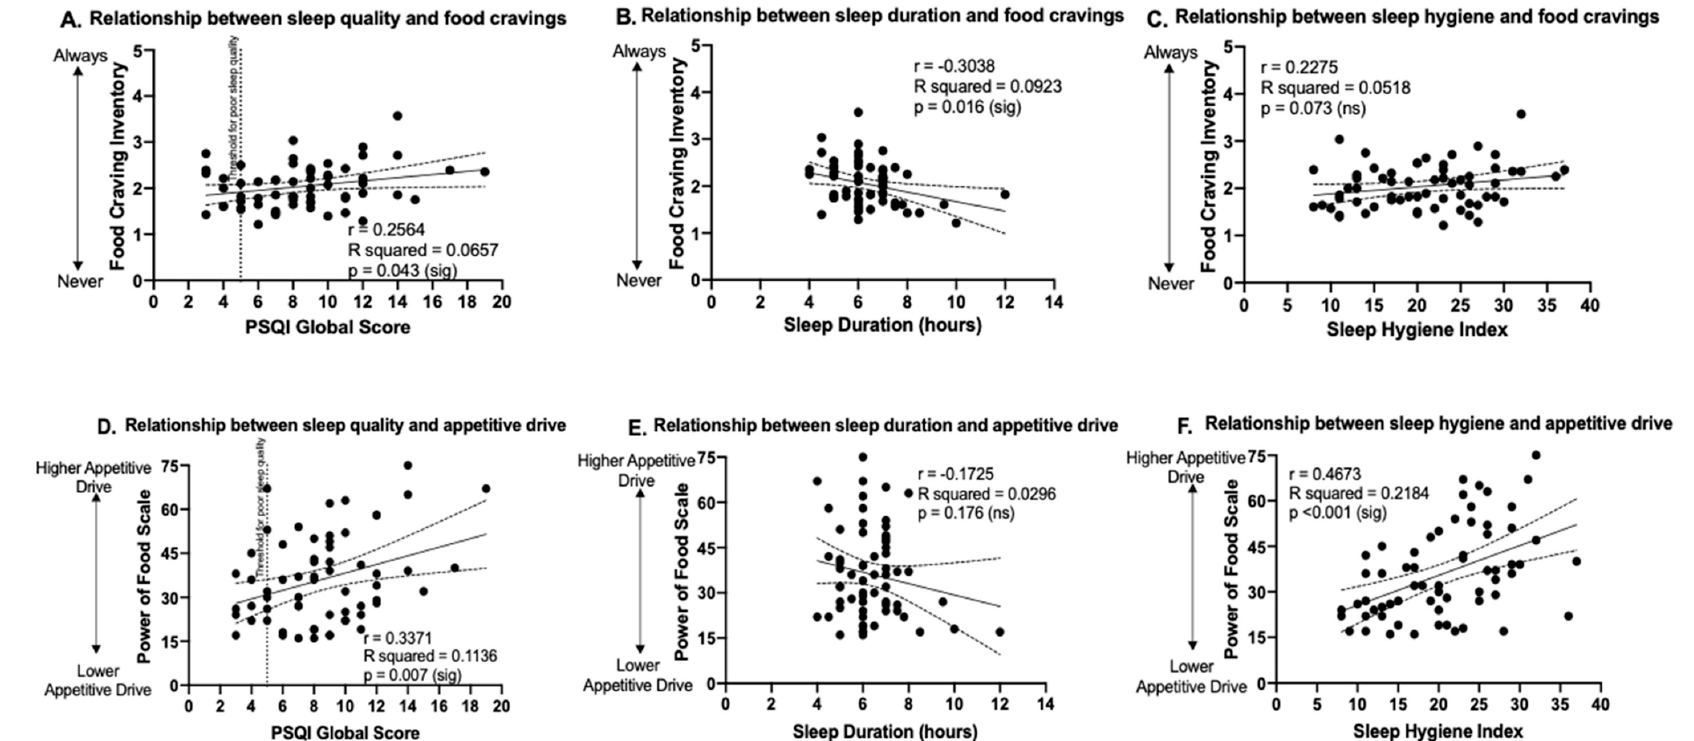
Figure 1. The relationship between sleep measures and food cravings and appetitive drive. Relationships of sleep measures to Food Craving Inventory scores are shown in the top panels ( A – C ) and relationships of sleep measures to Power of Food Scale scores are shown in the bottom panels ( D – F ). Vertical dotted line in ( A ) and ( D ) indicates threshold for clinically significant poor sleep quality (PSQI global score > 5). Dashed lines above and below the fitted regression lines indicate the 95% confidence interval. Statistically significant p -values ( p < 0.05) are denoted as (sig) and non-significant results ( p ≥ 0.05) denoted as (ns). PSQI: Pittsburgh Sleep Quality Index.